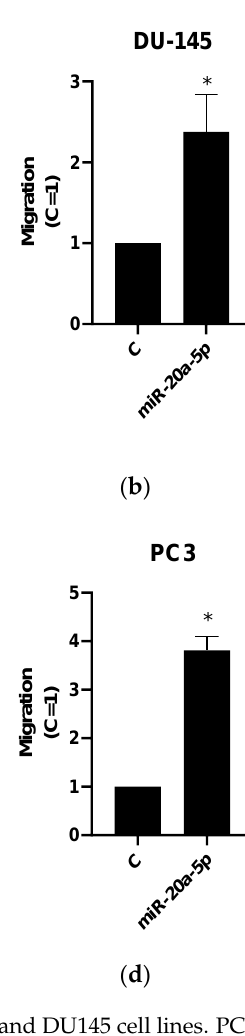
Figure 3. Wound healing analysis of transfected miR-20a-5p cells compared to controls in PC3 and DU145 cell lines. PC3 and DU145 cell lines showed significant ( p < 0.05) migration compared to controls. Results are plotted (mean ± SEM) in relation to controls (C = 1). Figure 3 shows representative results of three experiments, performed in duplicates, while complete results from all experiments are presented in Supplementary Table S1. ( a , b ) Wound healing assay for DU145 cell lines; ( c , d ) Wound healing assay for PC3 cell lines. *Significantly different from control ( p < 0.05, Student t-test).